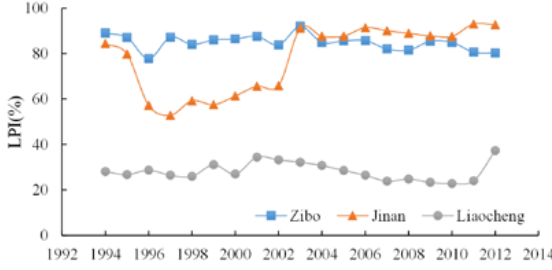
Figure 7. The variation of LPI metric of Zibo, Jinan, and Liaocheng